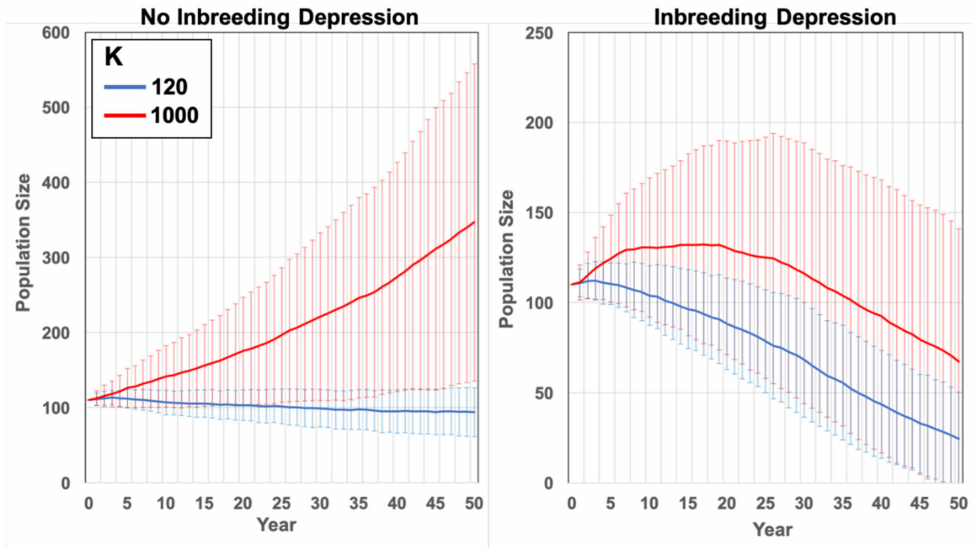
Figure 2. Simulated change in the mean population size ± 1 SD for 200 replicate simulations using mortality estimates for lowland individuals at Yellingbo in the 1990s, with inbreeding depression either excluded or included in models. Simulations were carried out with the carrying capacity ( K ) set to 120 to reflect the limited habitat availability in the reserve, and 1000 to determine whether greater habitat availability could yield a demographically stable population without inbreeding depression. Simulation settings are detailed in Table 1 ( 1990s Condition ).